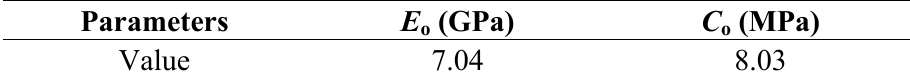
Table 2. Equivalent mechanical parameters of surrounding rock identified by the GA-ANN at location R 0+263.